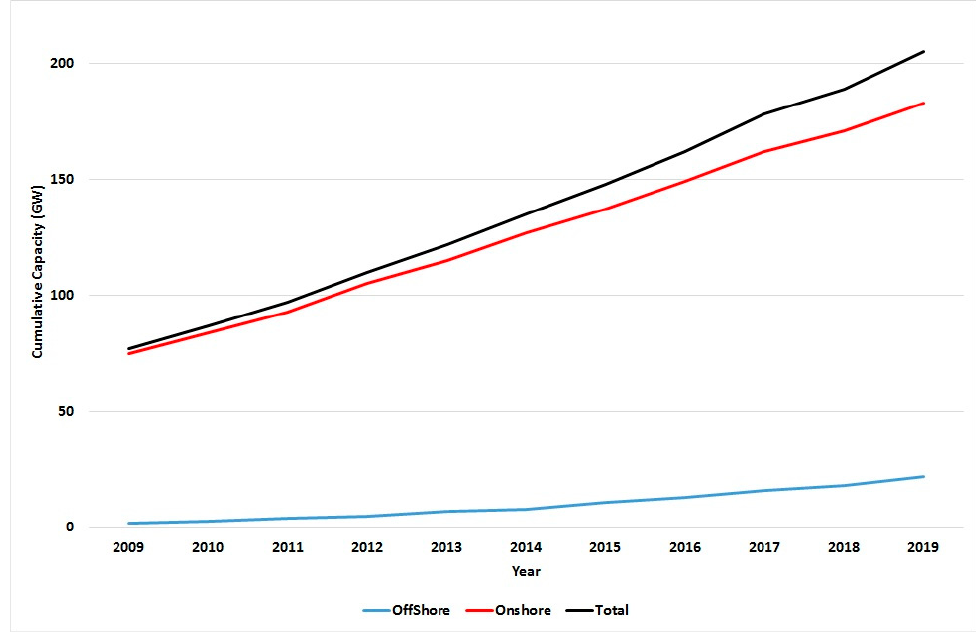
Figure 1. Trend on installed onshore and offshore wind power capacity in Europe. Source: drawn up by the authors with data from [5].